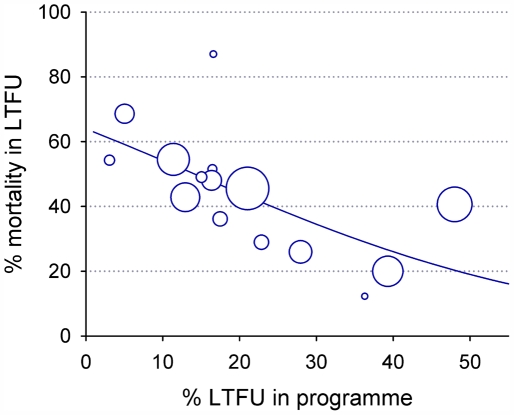
Estimated change in mortality among patients LTFU with proportion of patients LTFU in programme.Analysis based on 15 studies from sub-Saharan Africa. The area of each circle is inversely proportional to the variance of the estimate for that study.